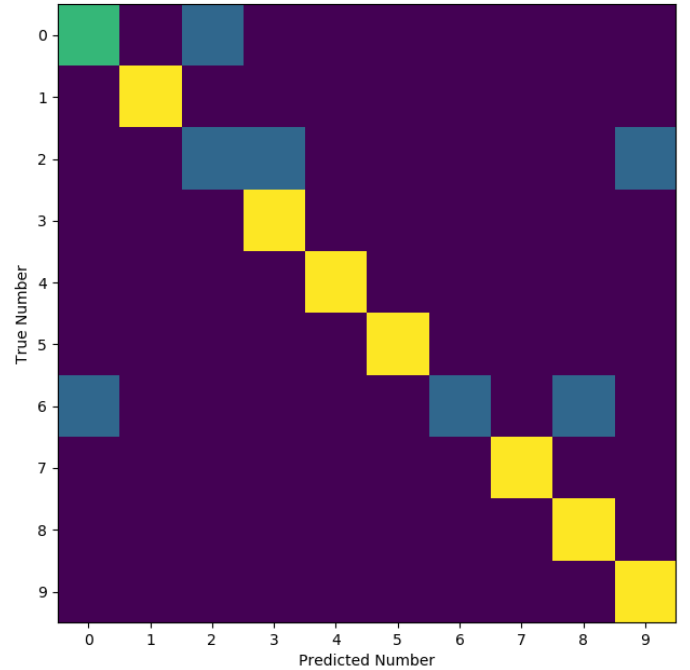
Figure 4. Confusion matrix of spoken digit